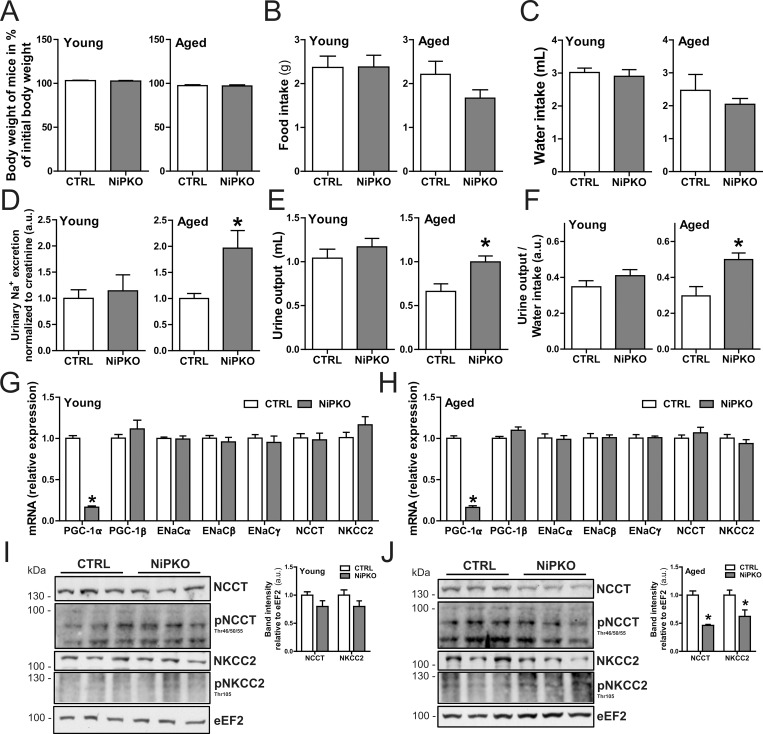
Aged NiPKO mice cannot adapt their salt- and water homeostasis to a reduced dietary salt intake.Control (CTRL) and NiPKO mice were fed a standardized diet containing <0.02% NaCl (low salt diet, LSD) for 5 weeks, starting at either 1 month or 12 months after doxycycline administration. (A) Body weight at end of LSD feeding period expressed as percentage of initial body weight (n = 6–8). (B) Food intake over 24 hours (n = 6–8). (C) Water intake over 24 hours (n = 6–8). (D) Urinary sodium (Na+) excretion normalized to urinary creatinine excretion (n = 6–8). (E) Urine output over 24 hours (n = 6–8). (F) Urine-to-water ratio over 24 hours (n = 6–8). (G-H) mRNA levels of indicated genes in kidney normalized to Tbp mRNA levels, at (G) 1 month and (H) 12 months after DOX administration (n = 6). (I-J) Representative immunoblots of NCCT, p-NCCT (Thr45/50/55), NKCC2, p-NKCC2 (Thr105) and eEF2 in kidney. Bar graph shows quantification of band intensities of total NCCT and NKCC2 relative to eEF2 (n = 6). Error bars represent mean ±SEM. Significant differences (p-value <0.05) between genotypes are indicated by an asterisk (*).